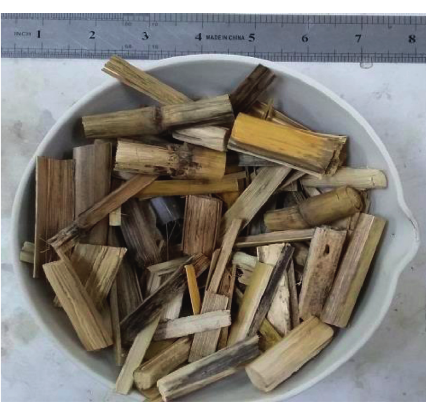
Figure 1: Corn stalk after